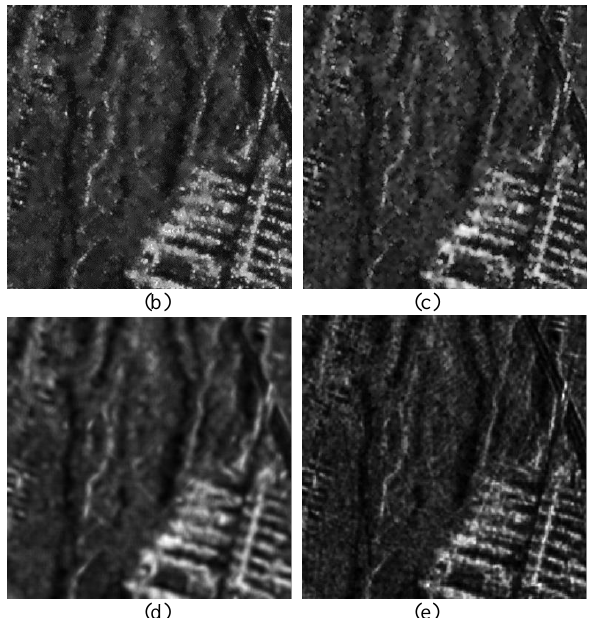
Gamma MAP filter